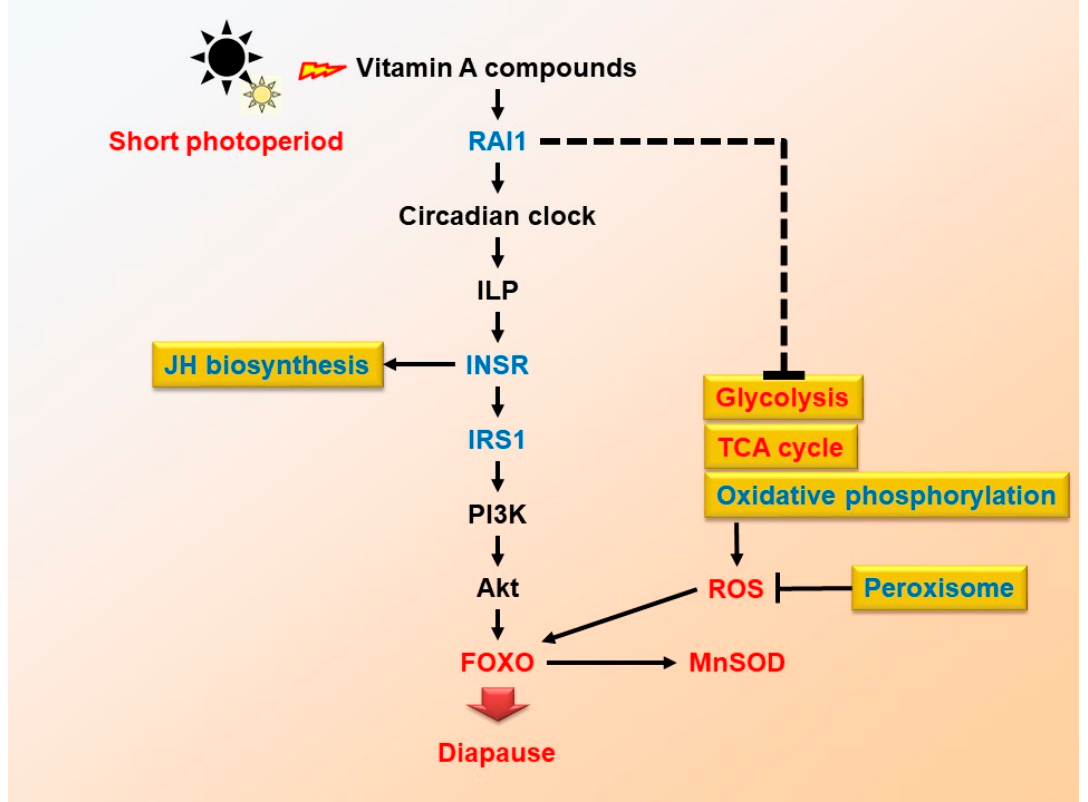
Figure6. Potentialpathwayofmaternale ff ectoneggdiapauseinductionof L.migratoria . Figure 6. Potential pathway of maternal effect on egg diapause induction of L. migratoria . The ‘blue’ mean ‘down-regulated’, ‘red’ means ‘up-regulated’ whereas ‘black’ means ‘not confirmed in our experiment’.